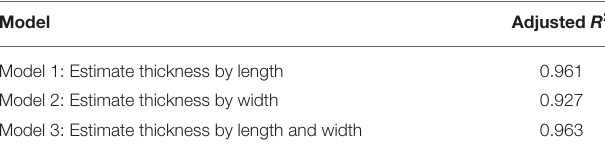
TABLE 2 | A review of three regression models used to estimate thickness by determining the length, width, and combination of length and width (adjusted R 2